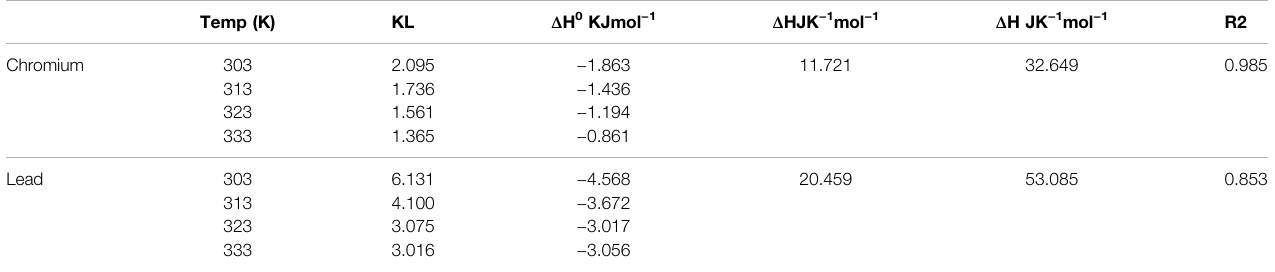
TABLE 1 | Thermodynamic parameters for chromium and lead